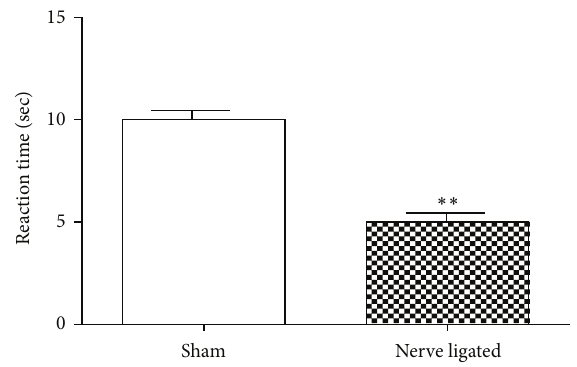
Figure 5: Changes in reaction time in sham-operated and nerve ligated mice, 14 days after the sciatic nerve ligation. ∗∗∗ 𝑃 < 0.001 significantly different from the control (sham) treated animals. Each value represents the mean ± SEM ( 𝑛 = 8 ).